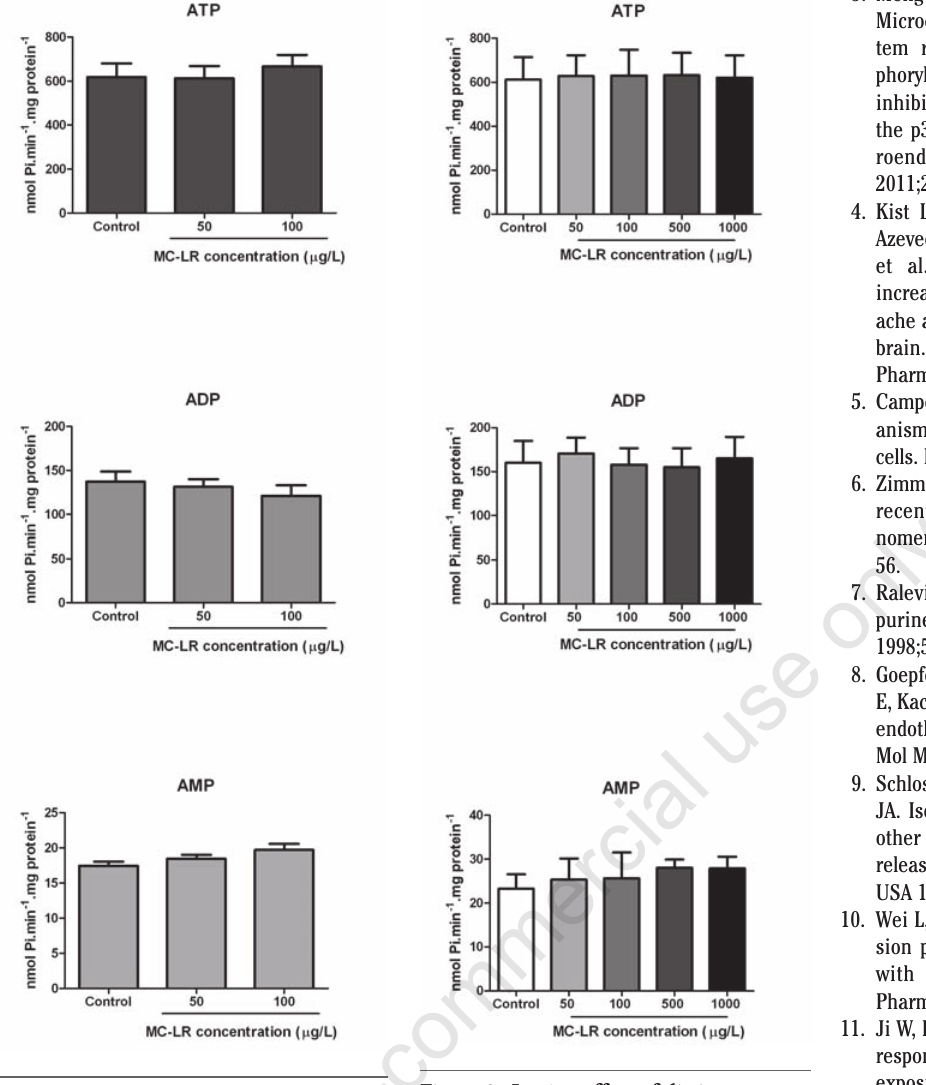
Figure 2. In vitro effect of distinct concen- trations of microcystins-LR on (A) adeno- sine triphosphate (ATP), (B) adenosine diphosphate (ADP) and (C) adenosine monophosphate (AMP) hydrolysis in zebrafish brain membranes. Bars represent the mean±SEM Data were analyzed by one-way ANOVA, P<0.05. The specific enzyme activity is reported as nanomole of inorganic phosphate released per minute per milligram of